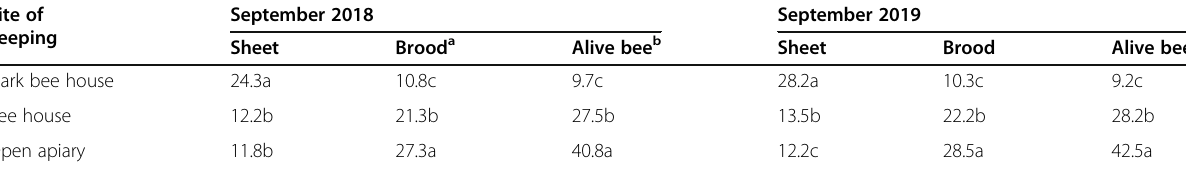
Table 2 Effect of keeping-bee hives in a dark bee house compared with keeping in a bee house with windows and in open air (beekeeping) on the average number of fallen Varroa mites on while card board sheets as well as on broods and alive bees, during September of 2018 and 2019 at Dakahlia governorate, Egypt Site of keeping